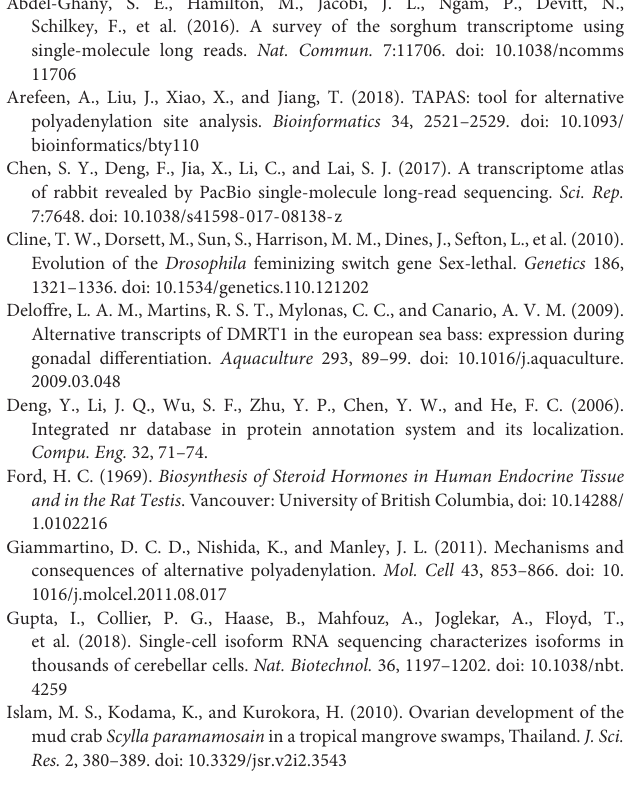
Supplementary Figure 2 | Saturation curve of full-length sequencing for gonads of S. paramamosain . The cyan line represents the number of isoforms and the red line represents the number of genes. Supplementary Figure 3 | Principal component analysis of DGEs.